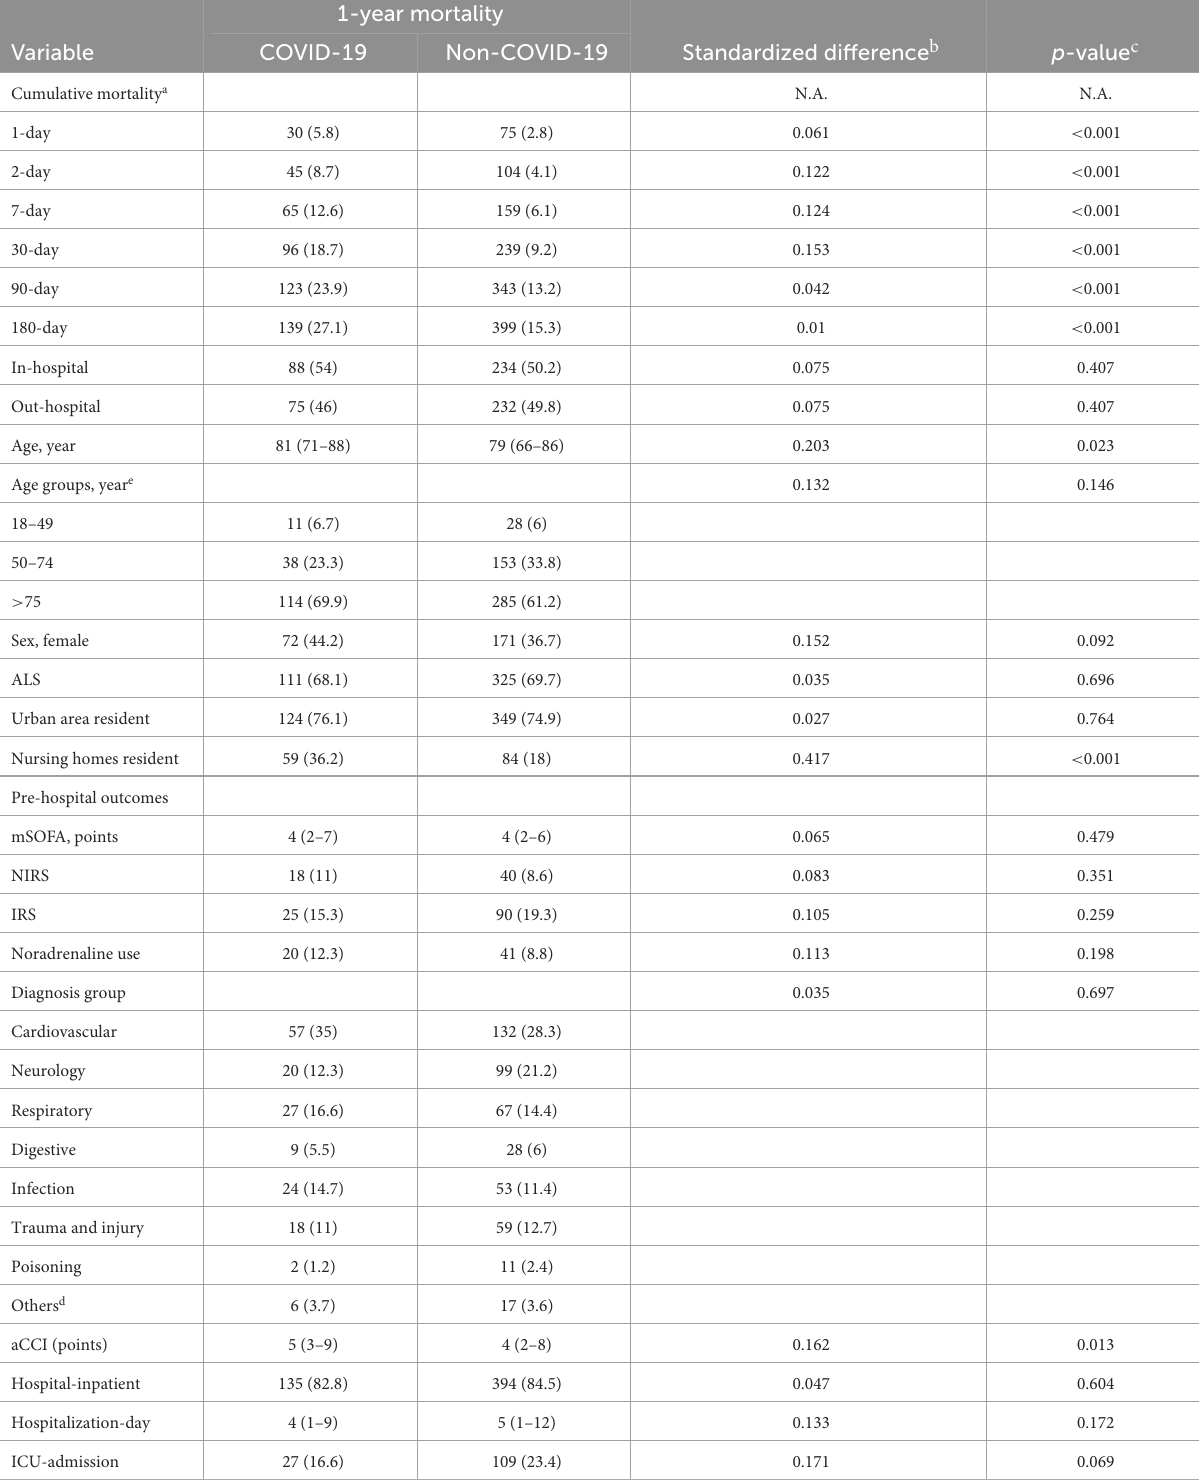
TABLE 3 Outcomes of long-term mortality